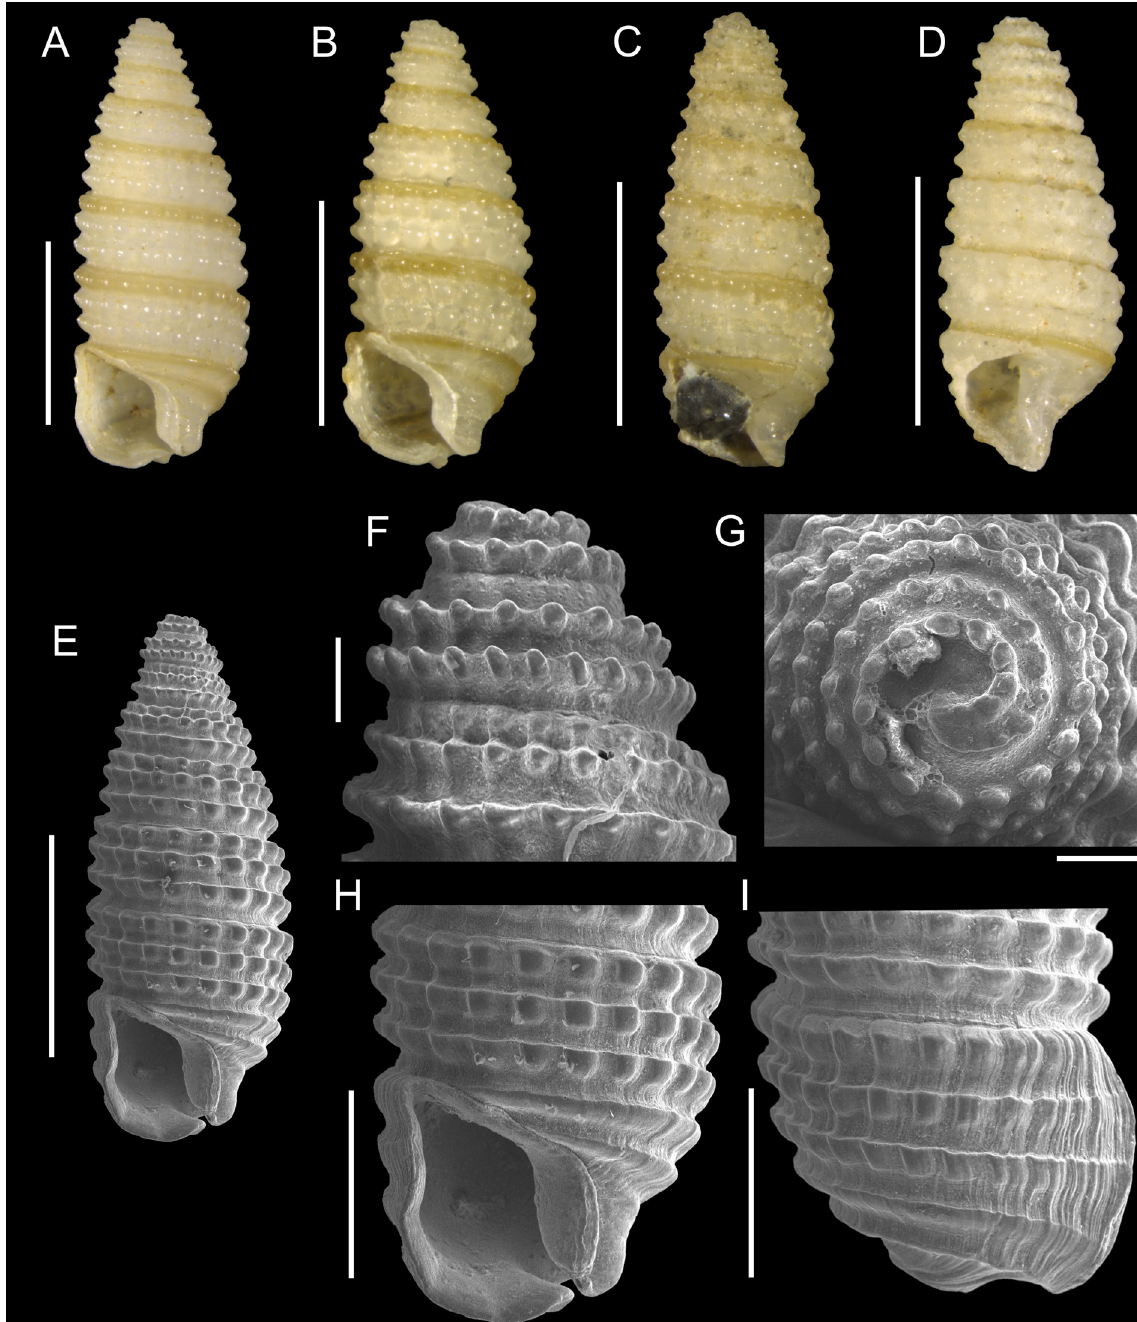
Fig. 5. Isotriphora leo sp. nov. A . MNRJ 29392*, holotype, 2.39 mm. B . MORG 25615*, 2.00 mm. C–D . MORG 25645*, 1.76 mm and 1.79 mm, respectively. E–I . HolotypE. Scale bars: A–E = 1 mm; F–G = 100 µm; H–I = 500